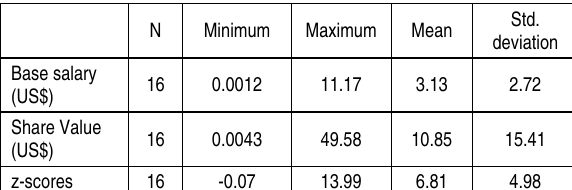
Table 2. Descriptive statistics from 2011 to 2014